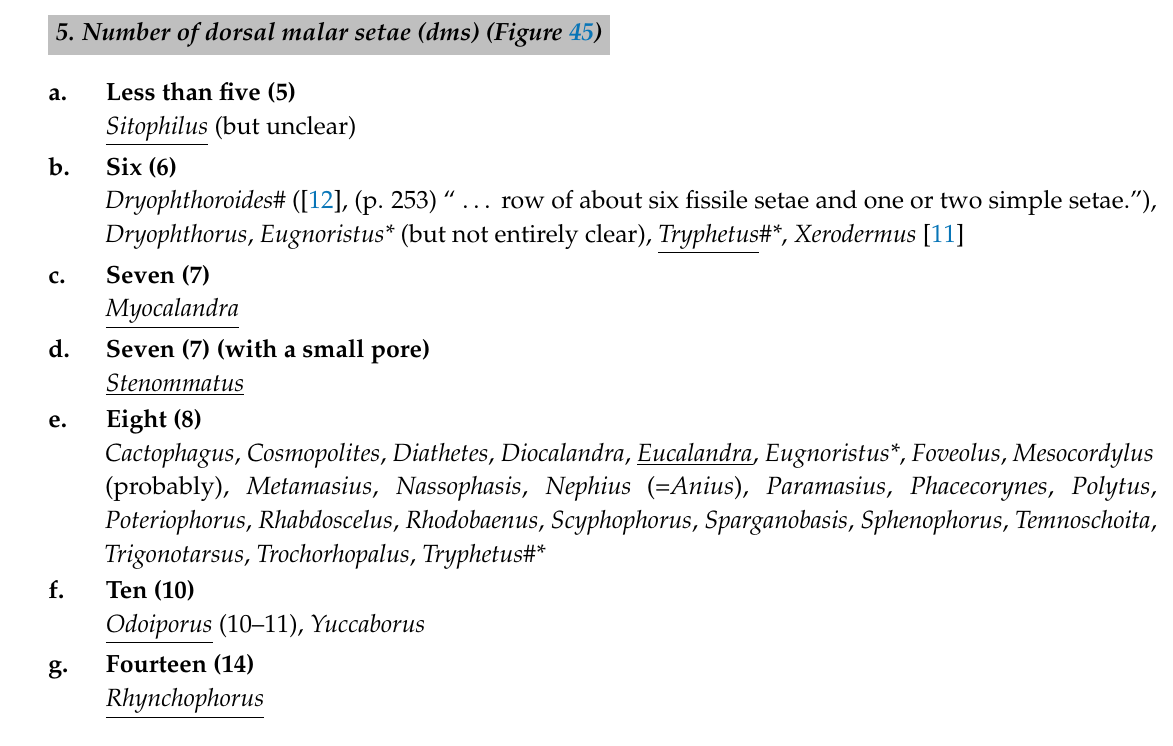
Figure 44. Hypopharynx, mala, and maxillary palp, larva, dorsal view: ( a ) Stenommatus ; and ( b ) Rhynchophorus .